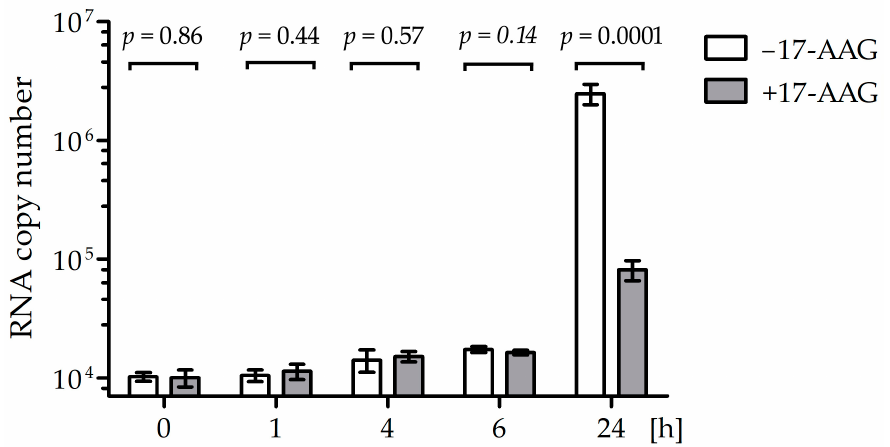
Figure 5. Right after infection, CVS-11 RNA synthesis is not affected by Hsp90 inhibition. NAC1300 cells pre-incubated for 2 h with 500 nM 17-AAG and control cells not treated with the inhibitor were infected on ice with CVS-11 at MOI = 100. After 1 h, unbound virus was washed off with cold PBS. The washed cells were incubated in a medium with or without 17-AAG. RNA was isolated at the indicated time and RABV RNA copies for the N gene were measured using RT-qPCR. The means and SD values of the four repeats of the experiment are plotted. The Student’s t -test was used to calculate the p values.